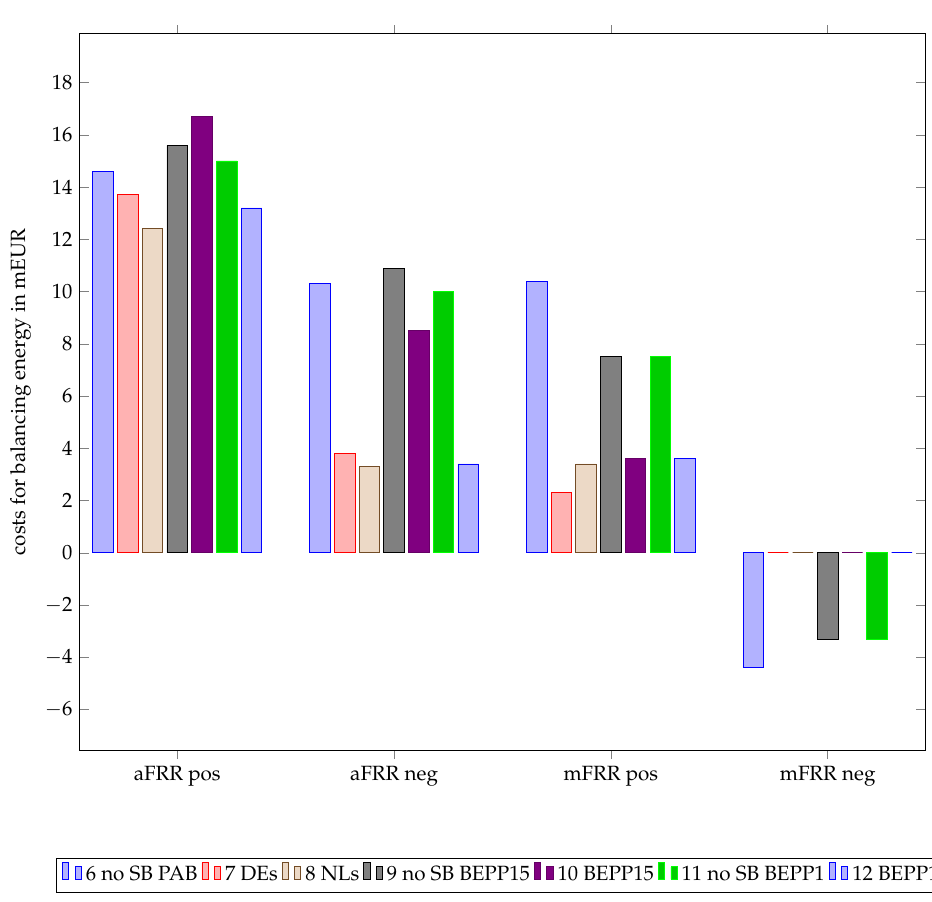
Figure 10. Smart Balancing simulation - Demand of balancing energy in synthetic scenarios Figure 10. Smart balancing simulation: demand of balancing energy in synthetic scenarios.